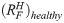
Effect of (RFH)healthy on forager population.